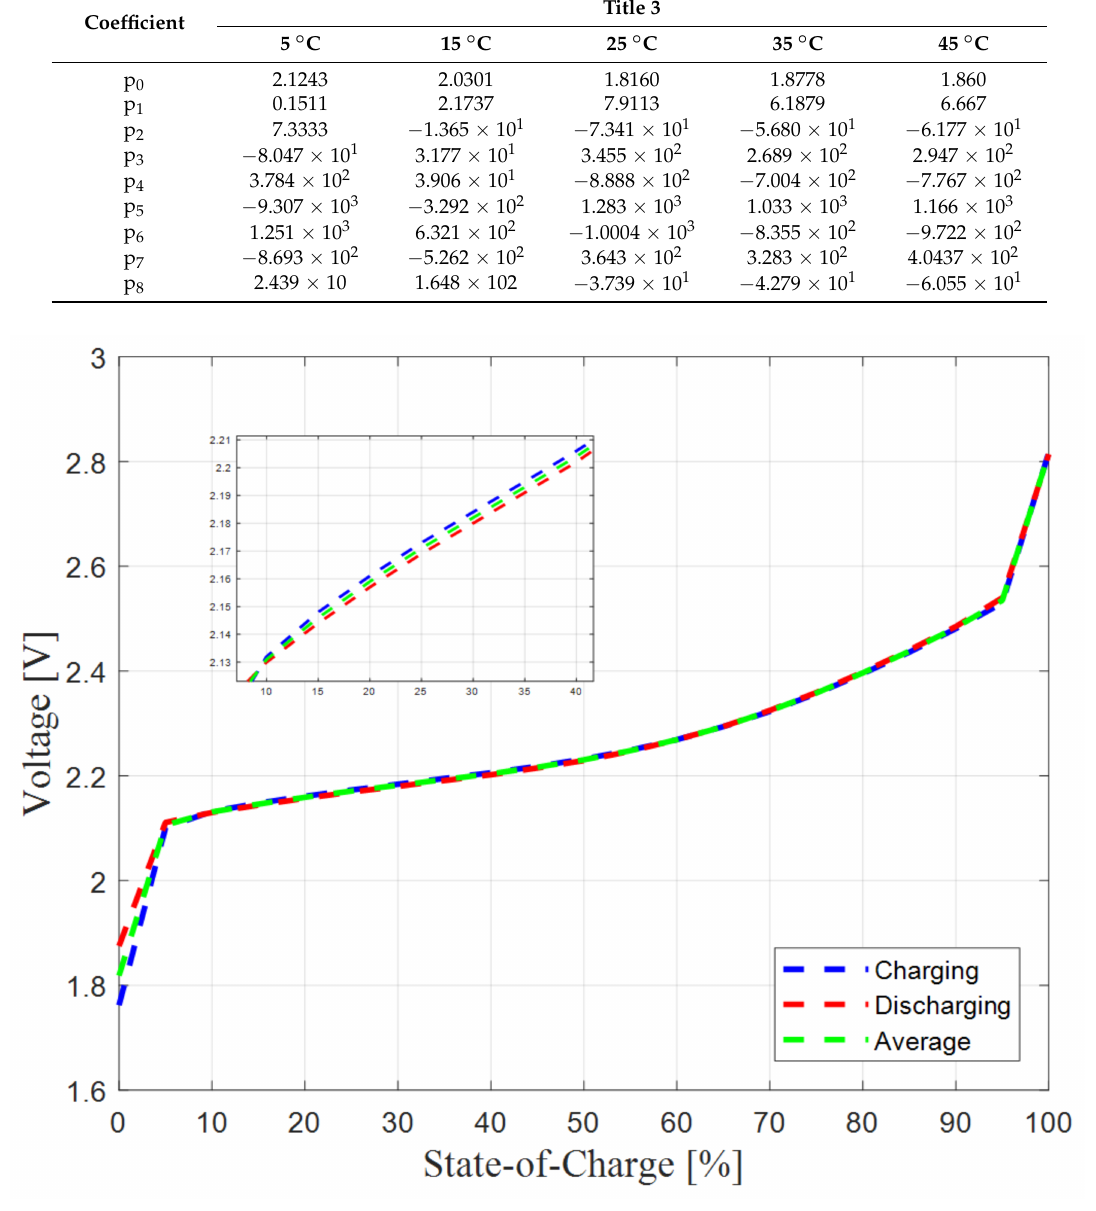
Figure 4. The OCV-SOC characteristic of the LTO-based battery measured at T = 25 ◦